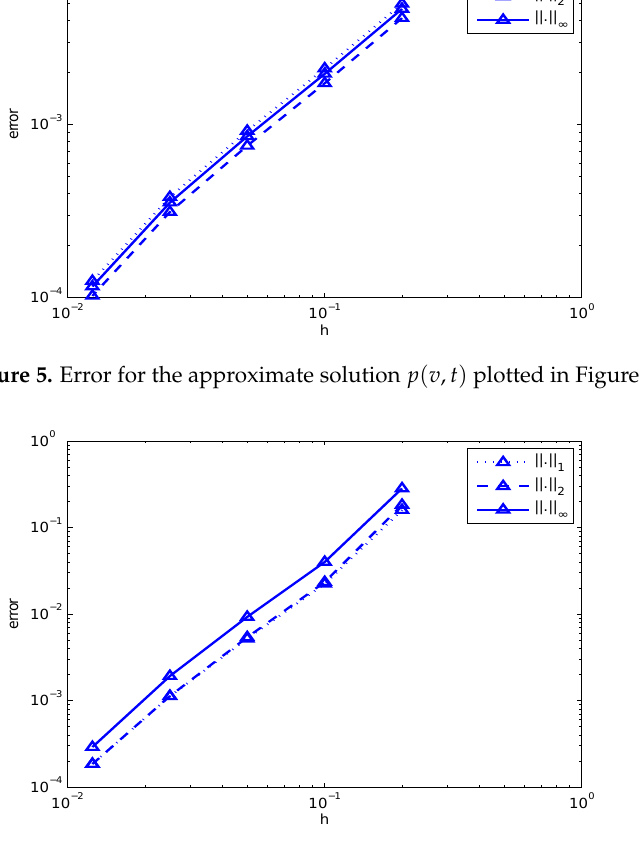
Figure 6. Error for the approximate solution p ( v , t ) plotted in Figure 3a.